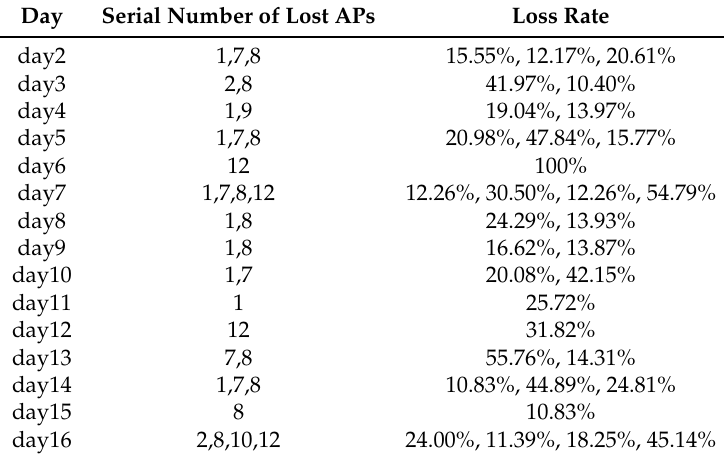
Table 6. Loss of important APs during the 15 days of testing.